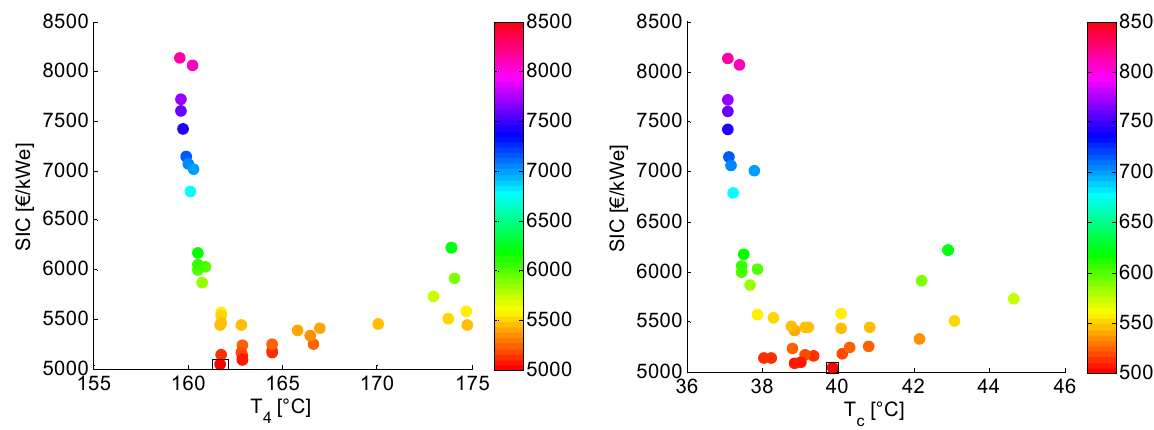
in function of (cid:1849)(cid:4662) (cid:3030)